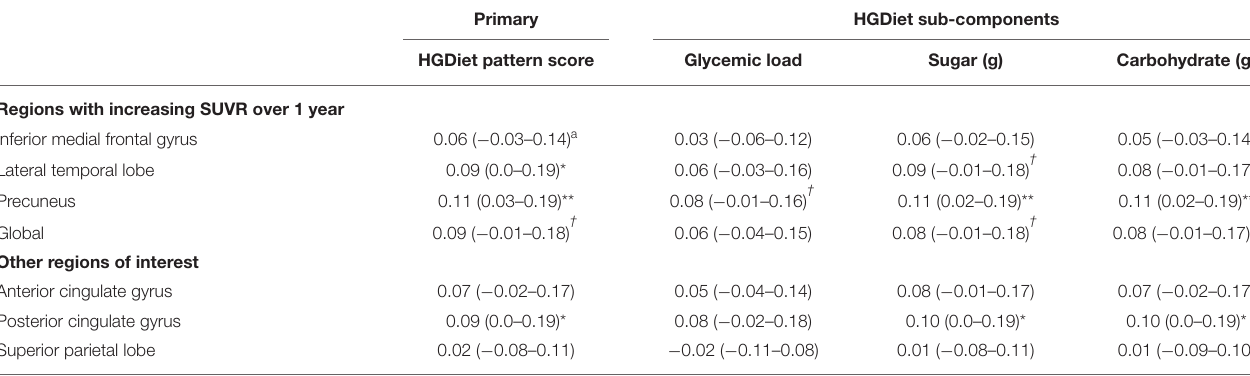
TABLE 3 | Sensitivity analysis restricted to participants with elevated amyloid at baseline examining relationship between high glycemic diet measures and regional change in cerebral amyloid burden a . Primary